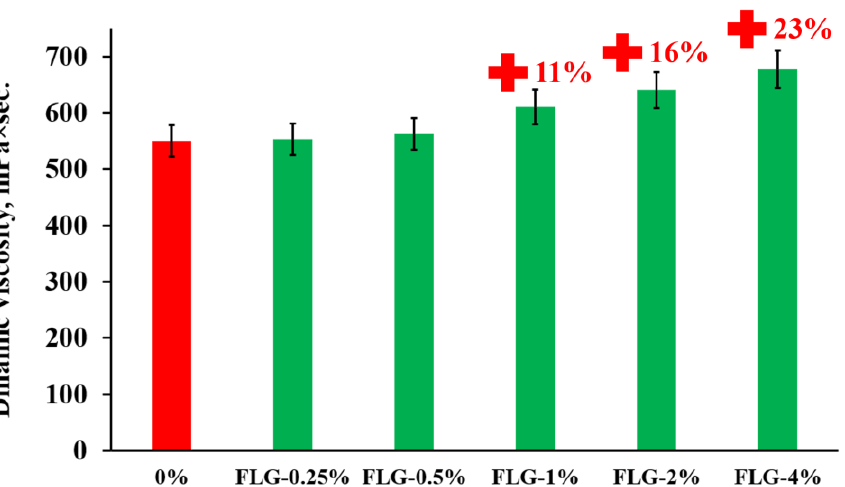
Figure 3. Dependence of the dynamic viscosity at 25 °C of stable suspensions of photopolymer resins after ultrasonic sonication at 50 °C depending on the concentration of FLG.